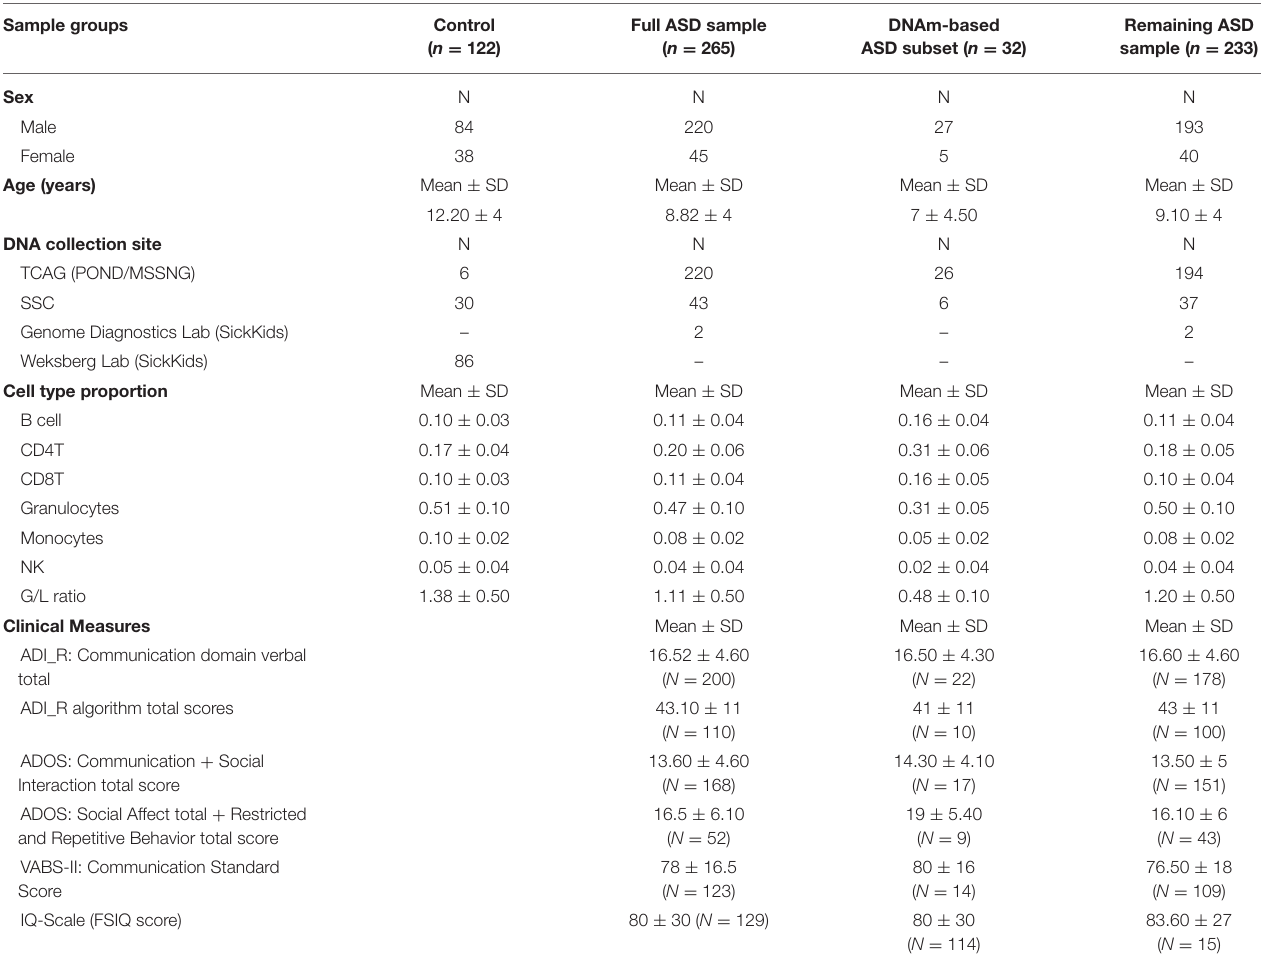
TABLE 1 | Demographic characteristics for ASD cases and neurotypical controls. Sample